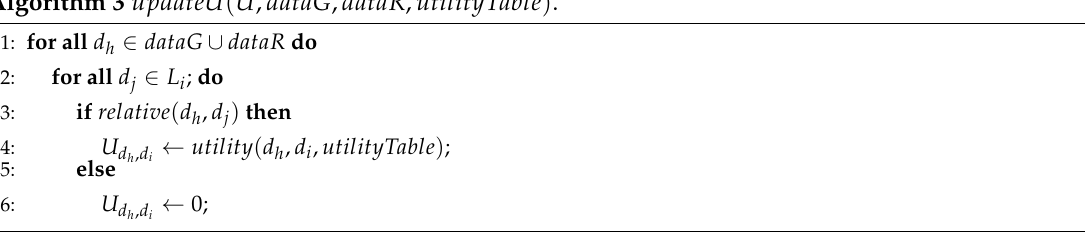
Algorithm 3 updateU ( U , dataG , dataR , utilityTable )